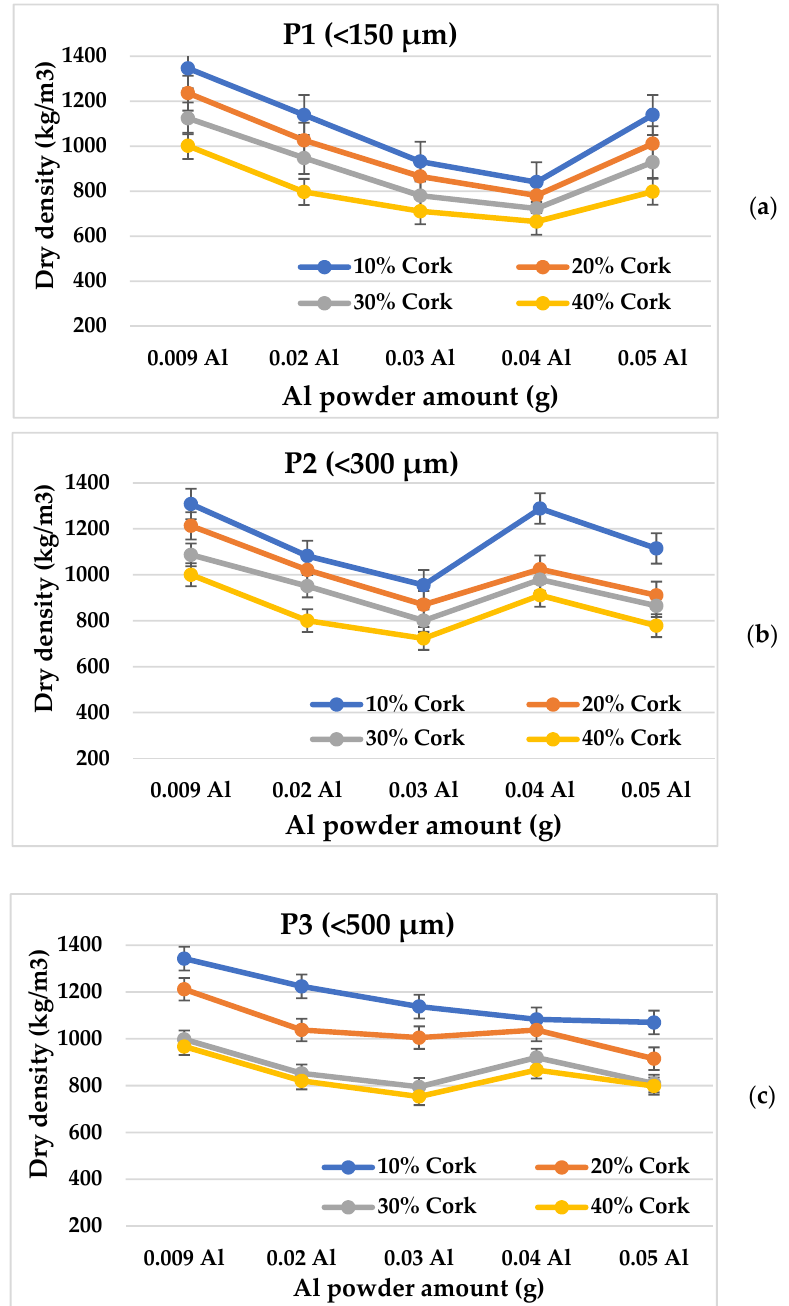
Figure 3. Dry density versus Al powder amount changes for samples with different percentage of cork particles; ( a ) P1 (<150 µ m), ( b ) P2 (<300 µ m), and ( c ) P3 (<500 µ m).